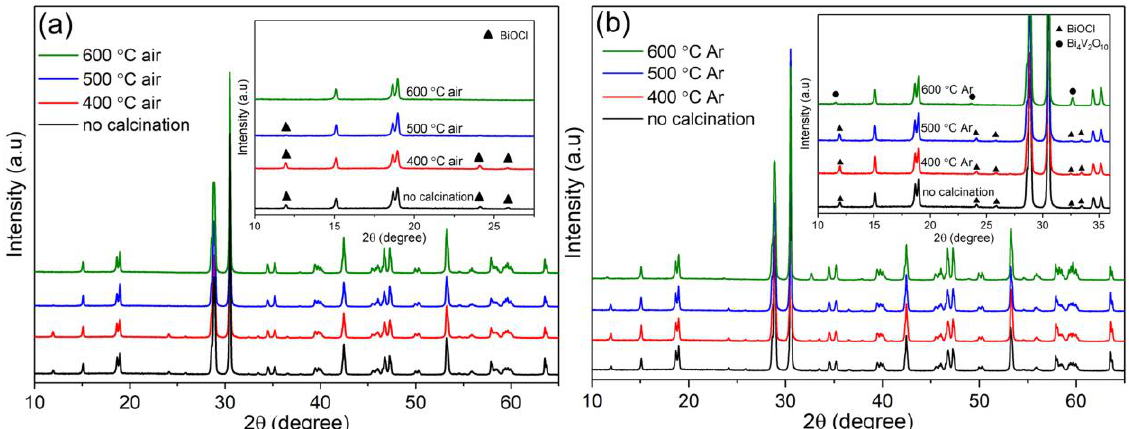
Figure 3. XRD patterns of KCl-BiVO 4 samples, calcined at different temperatures in ( a ) air and ( b ) Ar, both with magnified inset charts, where the peaks without ▲ or ● symbols correspond to BiVO 4 . The formation of Bi 4 V 2 O 10 in the present study can be explained as follows. The